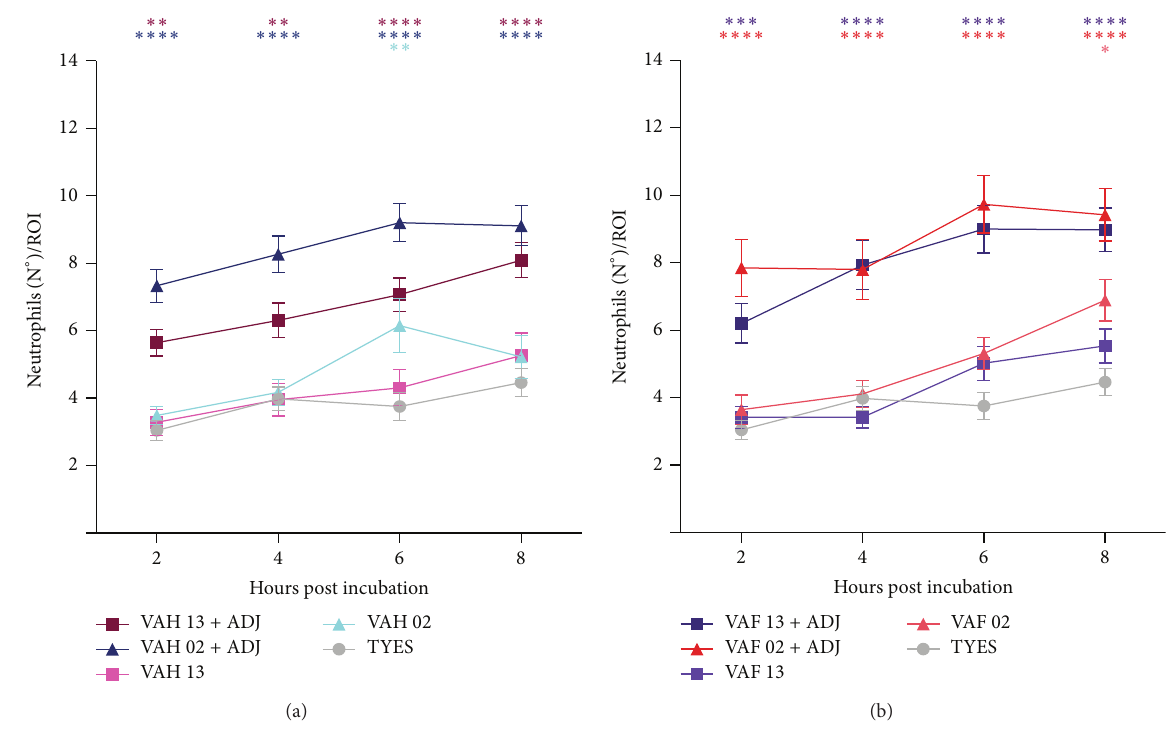
Figure 3: Effect on innate immune response triggered by one-year-old stored vaccines. ((a) and (b)) Graph quantifying neutrophil migration outside of the CHT (ROI), as triggered by bath-vaccination with formulas prepared from (a) heat or (b) formaldehyde inactivated bacteria. Statistical analysis was performed using two-way ANOVA. Data represent the mean ± standard error from three independent experiments with 15 larvae each. ∗ 𝑃 value < 0.05, ∗∗ 𝑃 < 0.005 , ∗∗∗ 𝑃 < 0.001 , and ∗∗∗∗ 𝑃 < 0.0001